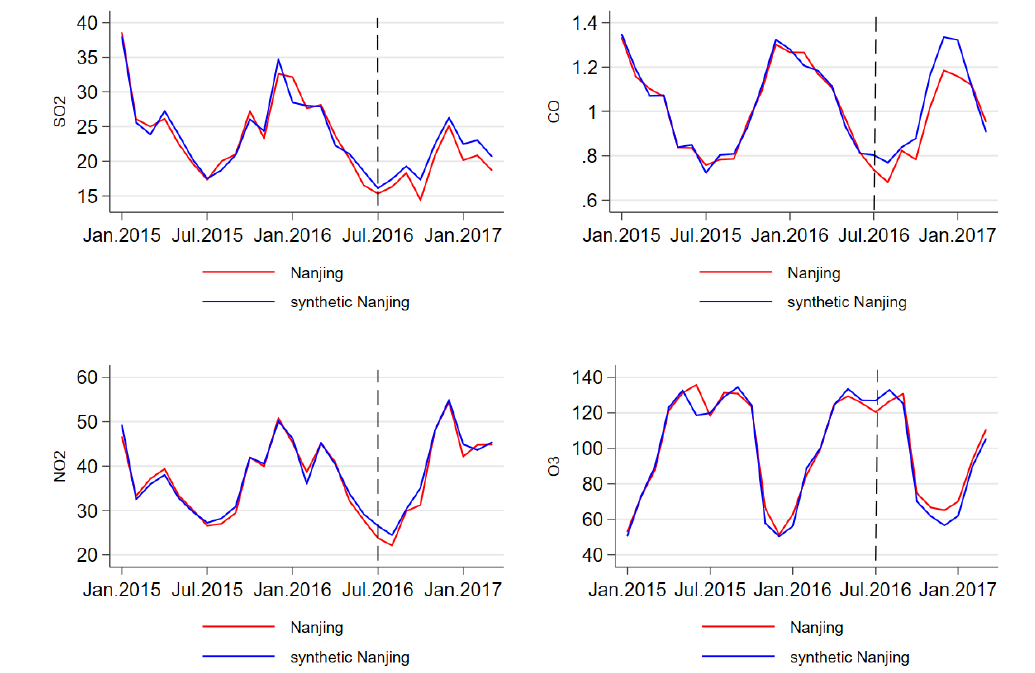
Figure 8. Individual pollutants in treatment regions and synthetic